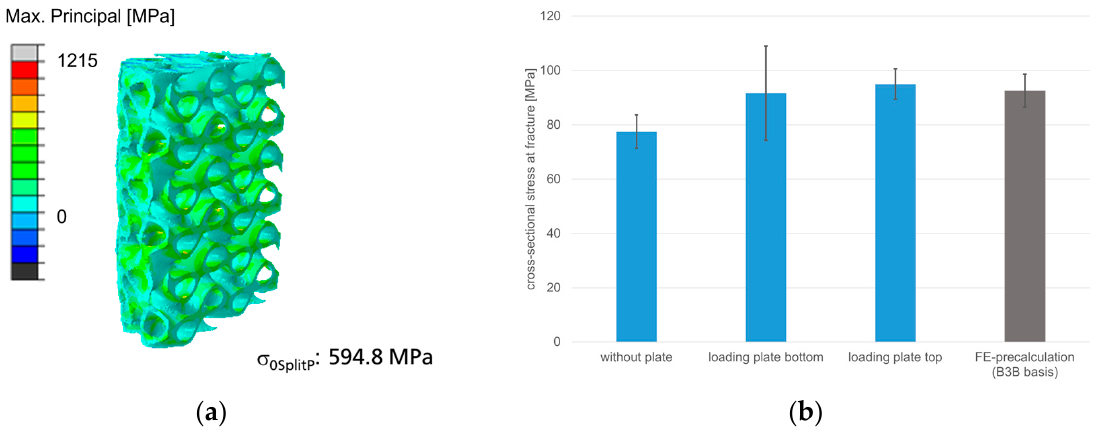
Figure 13. Uniaxial compression test of SplitP TPMS structure: ( a ) maximal principal stress at 8 kN; ( b ) the comparison of calculated fracture stress in comparison to the experimental results.